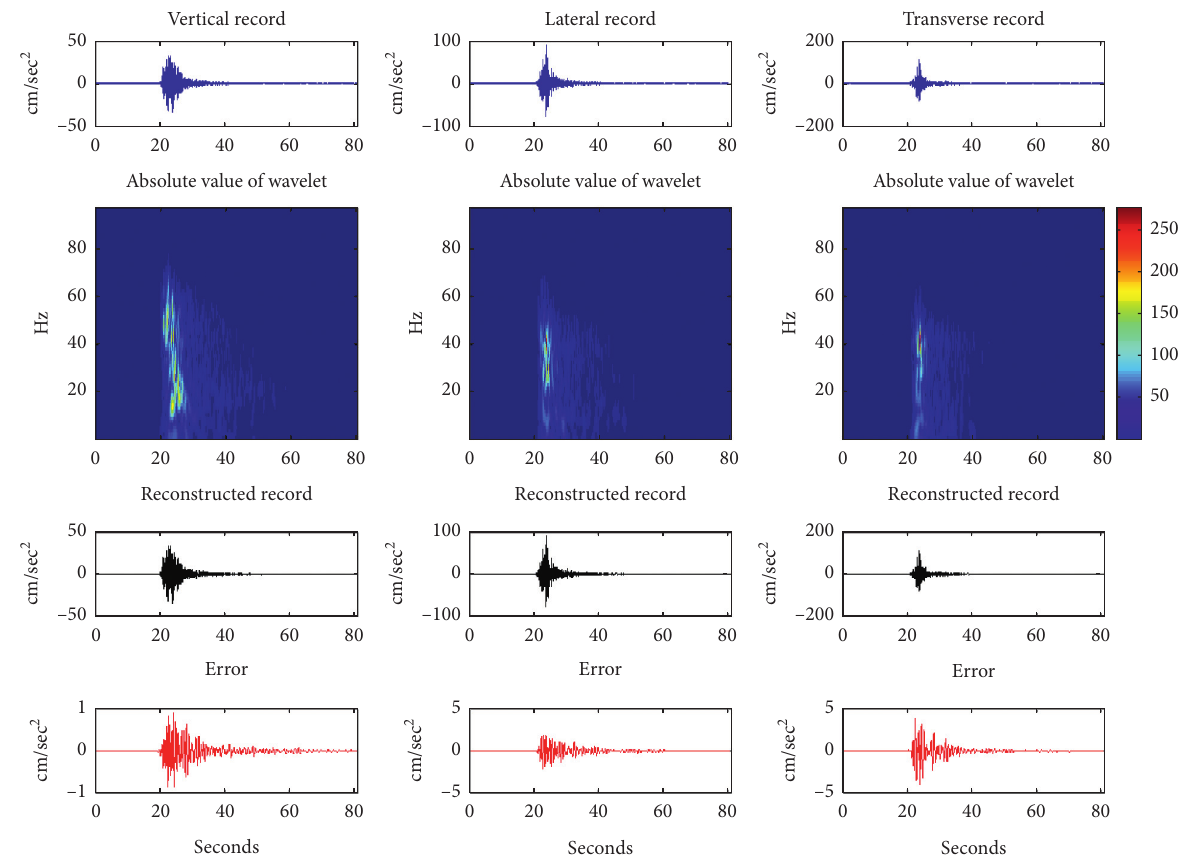
Figure 4: Continuous wavelet transform analysis of the Mosha 2020 earthquake accelerograms recorded in Mosha3